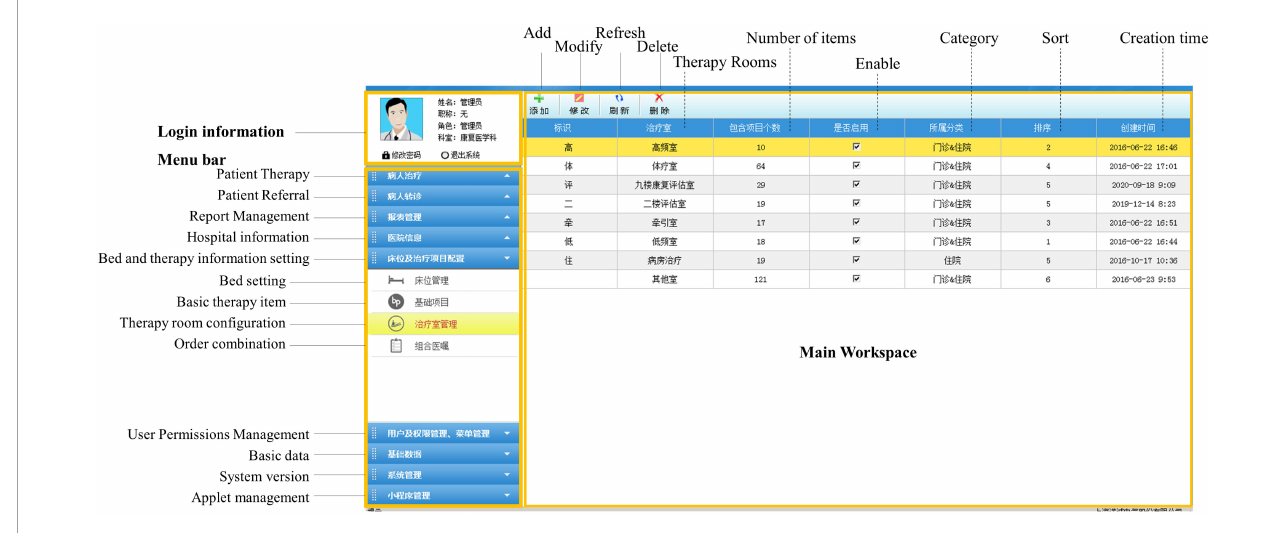
FIGURE3 Customized therapy items in rooms.